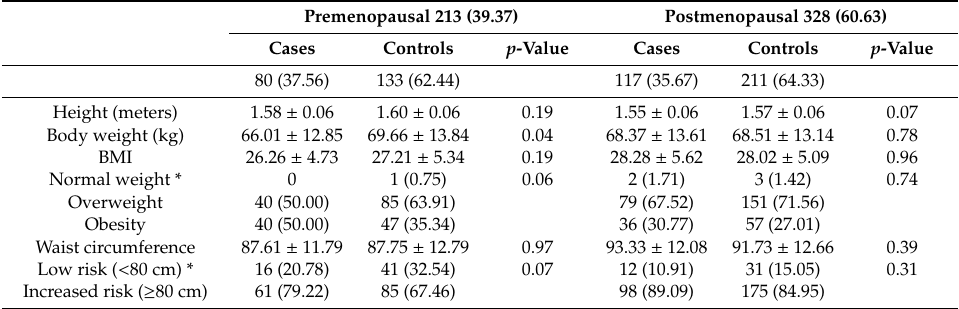
Table 3. Anthropometric characteristics among participants according to menopausal